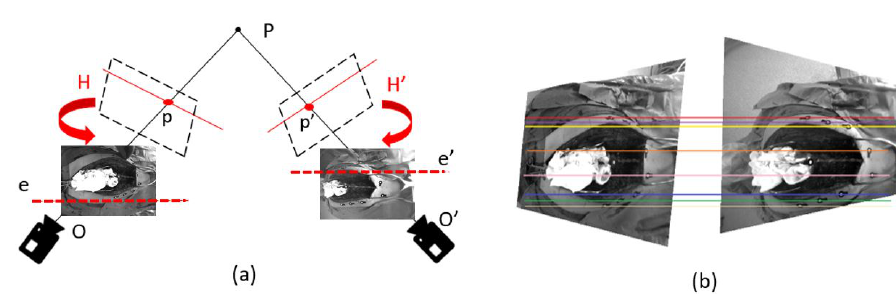
Figure 4. Image rectification, ( a ) the projective transformation H lead the matching of the epipolar lines. ( b ) shows an epipolar geometry matching after image rectification, the epipolar lines plotted for the optical markers run parallel after image rectification.